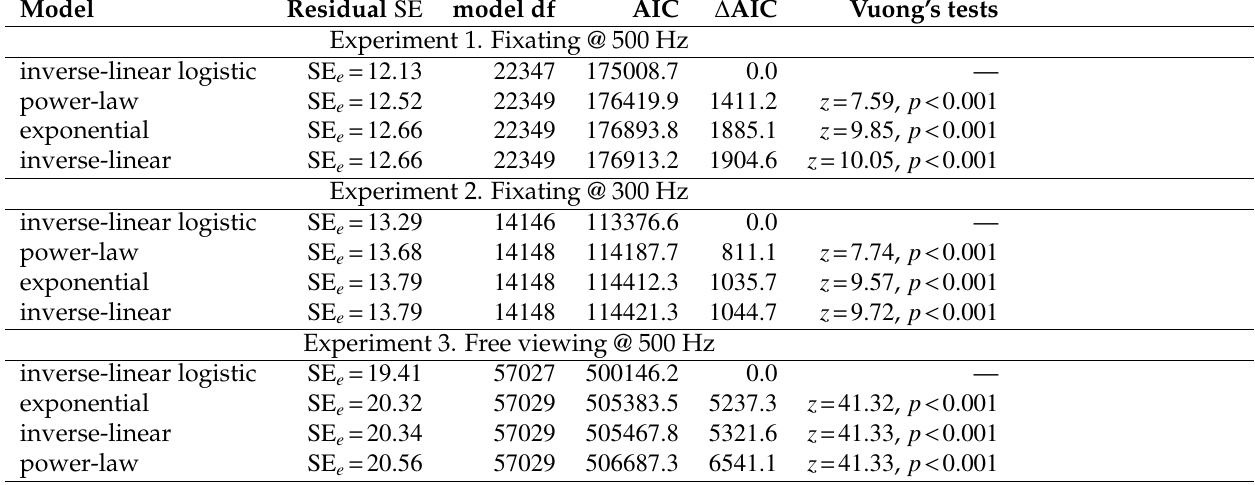
Tests of nonlinear model fit to microsaccades . For all ∆ AIC the inverse-linear logistic model is the base as it yields the smallest AIC criterion. Vuong’s tests (last column) compare all other models to the inverse-linear logistic fit. Data from Experiments 1 (top), 2 (middle), and 3 (bottom).